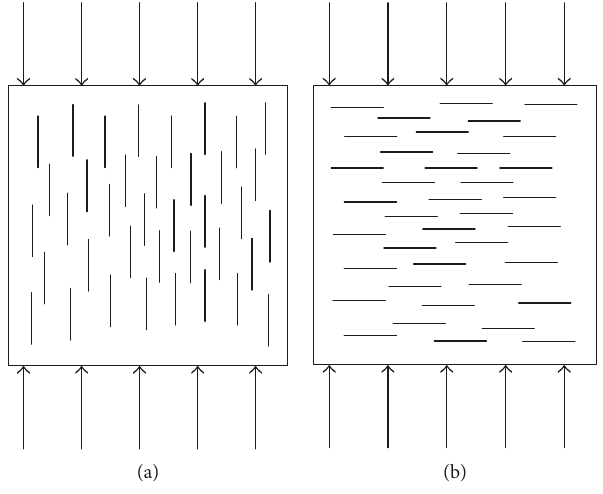
Figure 2: Diagrams of loading directions in the split tensile strength test. Loading applied (a) parallel and (b) perpendicular to the fibre direction.